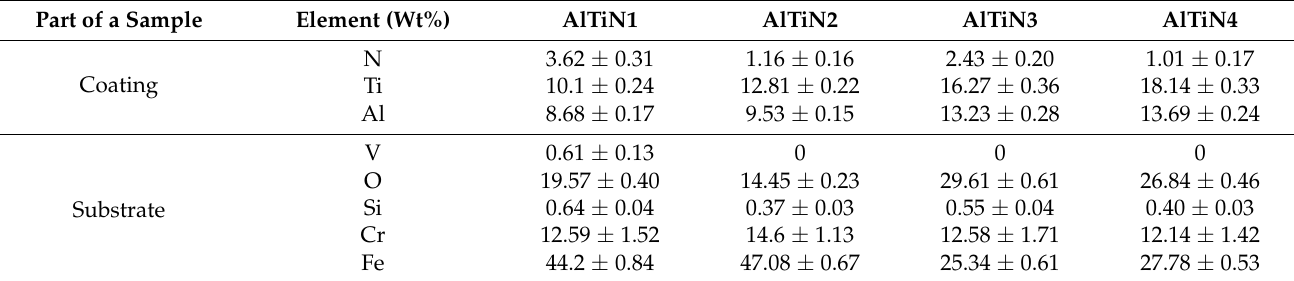
Table 7. Amounts of elements on the surface after laser stripping of the AlTiN coating. Part of a